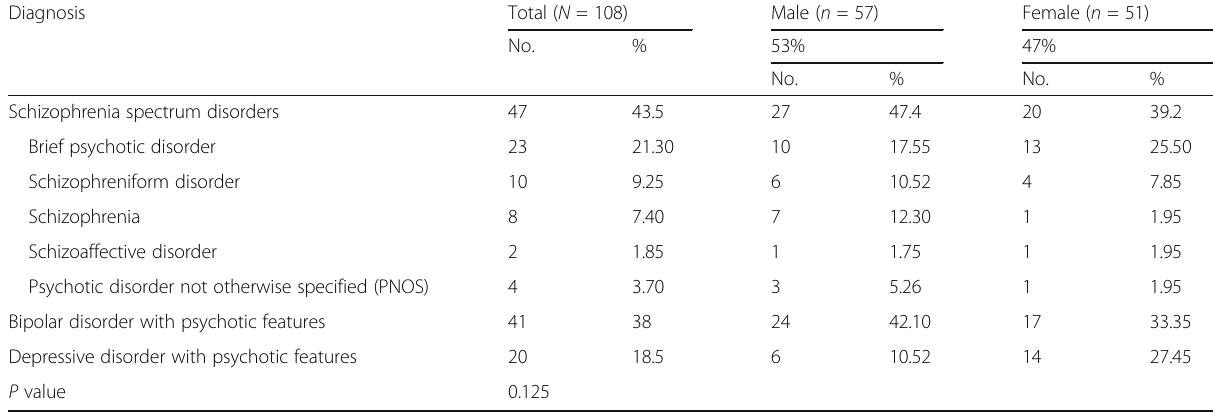
Table 1 Frequency and percentage of different diagnoses among study group at first presentation Diagnosis